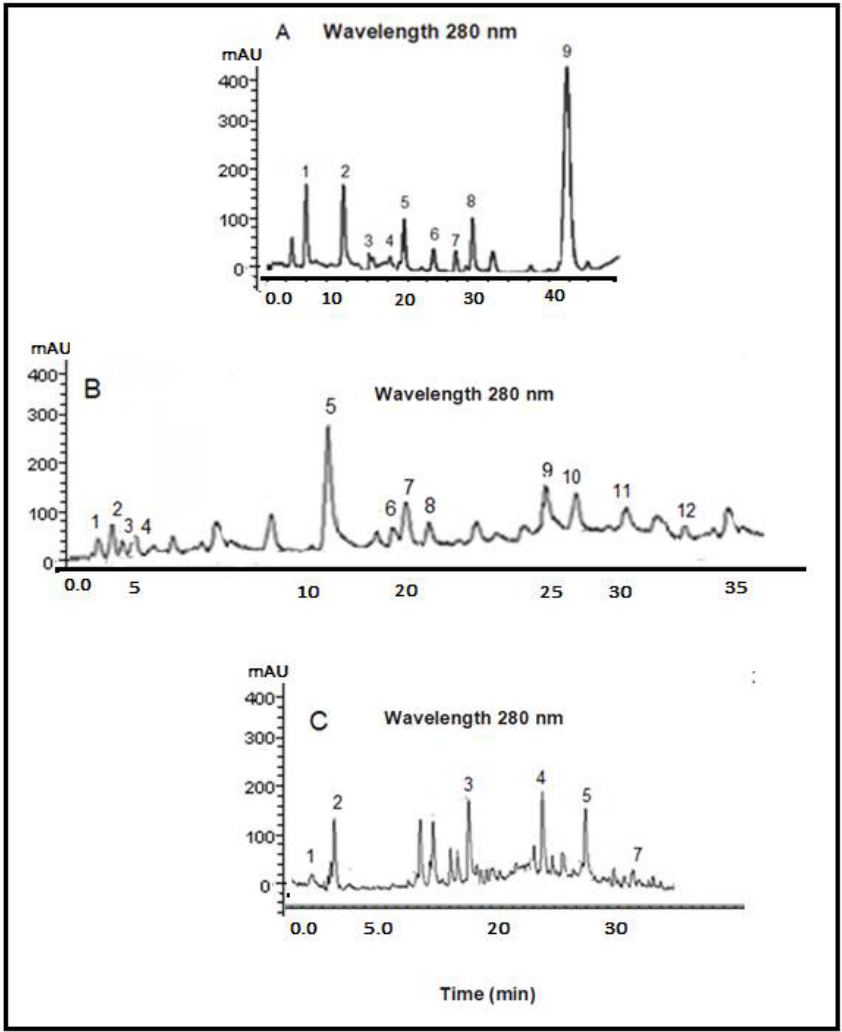
Figure 1. HPLC chromatogram of phenolic compounds of the hydroalcoholic extract. ( A ) Cinnamomum zeylanicum : (1) protocatechuic acid; (2) coumarin; (3) cinnamic acid; (4) vanillic acid; (5) p -coumaric acid; (6) caffeic acid; (7) rosmaric acid; (8) eugenol; (9) cinnamaldehyde. ( B ) Origanum majorana : (1) chlorogenic acid; (2) gallic acid; (3) pyrogallol; (4) resorcinol; (5) cinnamic acid; (6) carnosic acid; (7) syringic acid; (8) p -coumaric acid; (9) caffeic acid; (10) rosmarinic acid; (11) eugenol; (12) ferulic acid. ( C ) Origanum vulgare : (1) chlorogenic acid; (2) gentisic acid; (3) chicoric acid; (4) salvianolic acid B; (5) rosmarinic acid; (6) ferulic acid.